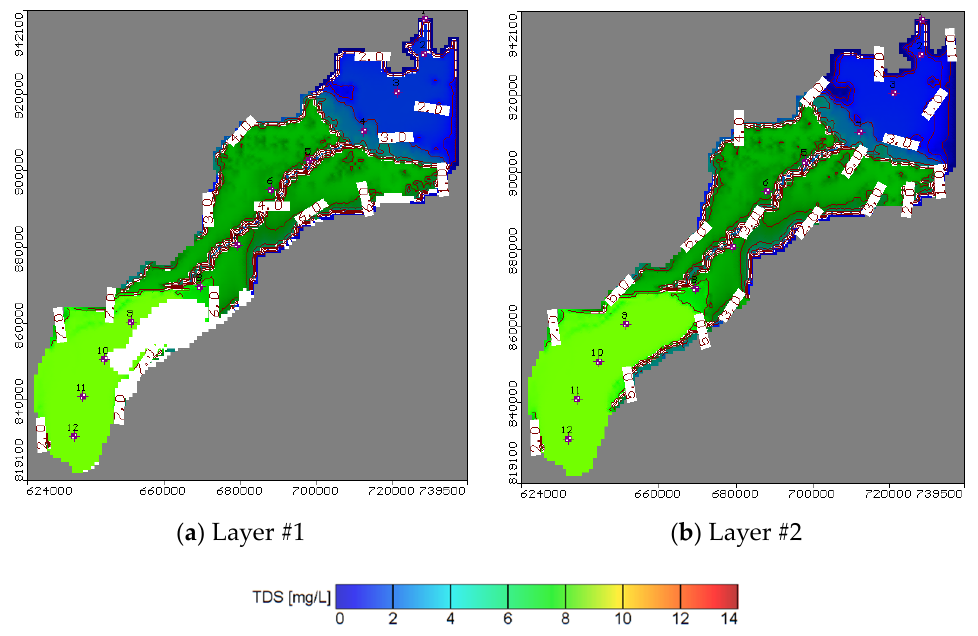
Figure 8. Aerial view of groundwater contamination of Nitrates fertilizer in NDA.